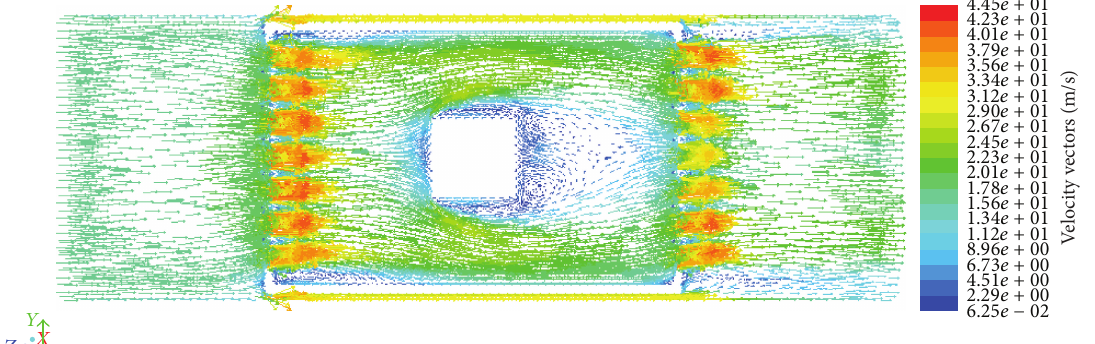
Figure 17: Velocity vector distribution of the square hole in the section 𝑍 = 0